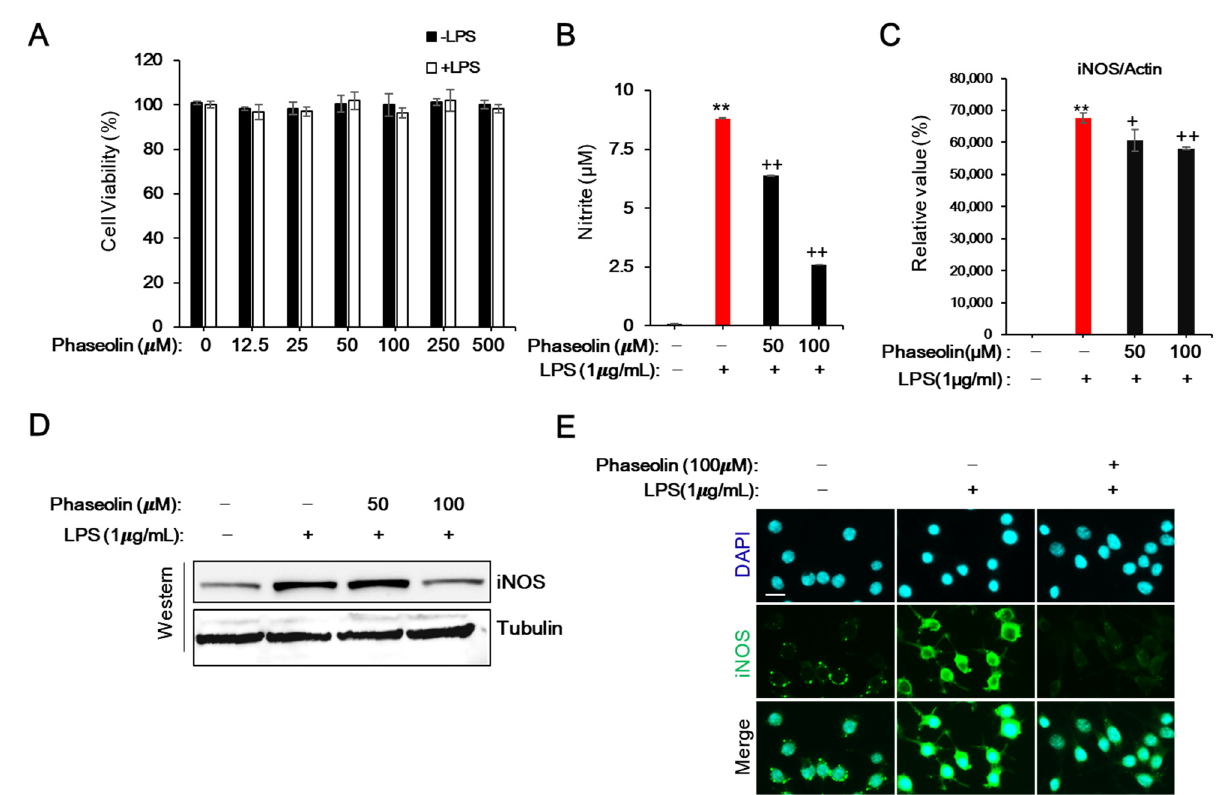
Figure 1. Effects of phaseolin on cell viability, nitric oxide (NO) production, and inducible nitric oxide synthase (iNOS) expression in lipopolysaccharide (LPS)-stimulated RAW 264.7 macrophages. Cell viability ( A ) was assessed using -(4,5- Dimethylthiazol-2-yl)-2,5-diphenyltetrazolium bromide (MTT) reduction assay and is expressed as the percentage of live cells over the control cells. The NO assay ( B ) was performed using the Griess reagent. Values represent the mean ± SD of 3 independent experiments. ** p < 0.01, vehicle vs. LPS-treated group; + p < 0.05 and ++ p < 0.01, LPS vs. LPS + phaseolin-treated group. Expression of iNOS at the mRNA level ( C ) was measured using real-time PCR. Expression of iNOS at the protein level ( D ) was measured using Western blotting. Representative immunofluorescence images ( E ) using anti-iNOS antibody (green). DAPI (4 ′ ,6-diamidino-2-phenylindole) was used for nuclear staining (blue). A scale bar indicates 10 μ m.